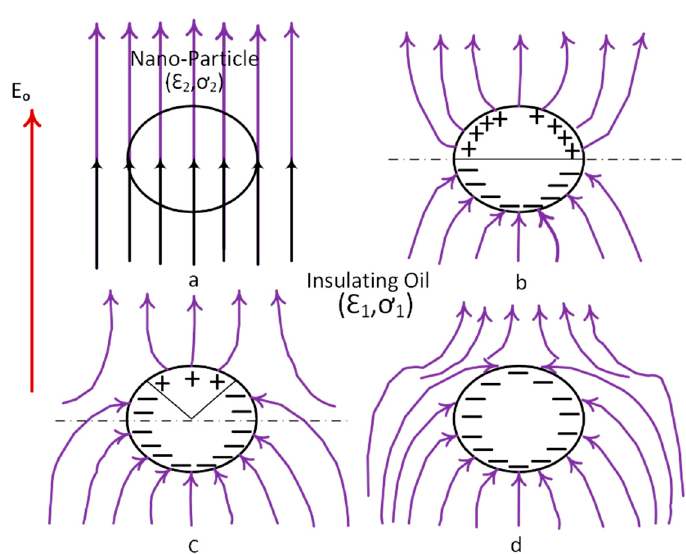
Figure 5. Charge relaxation model for improved breakdown voltage in NFs. The nanoparticles get rapidly polarized upon the application of electric field as seen from ( a ) to ( b ), the fast-moving electrons are captured by the nanoparticles as a result converting them into slow moving negative charge carriers as seen in ( c ). Due to low mobility of these charge carriers the net space charge is hindered and suppresses the streamer propagation in the oil as shown in ( d ). Hence, results in improved breakdown strength.